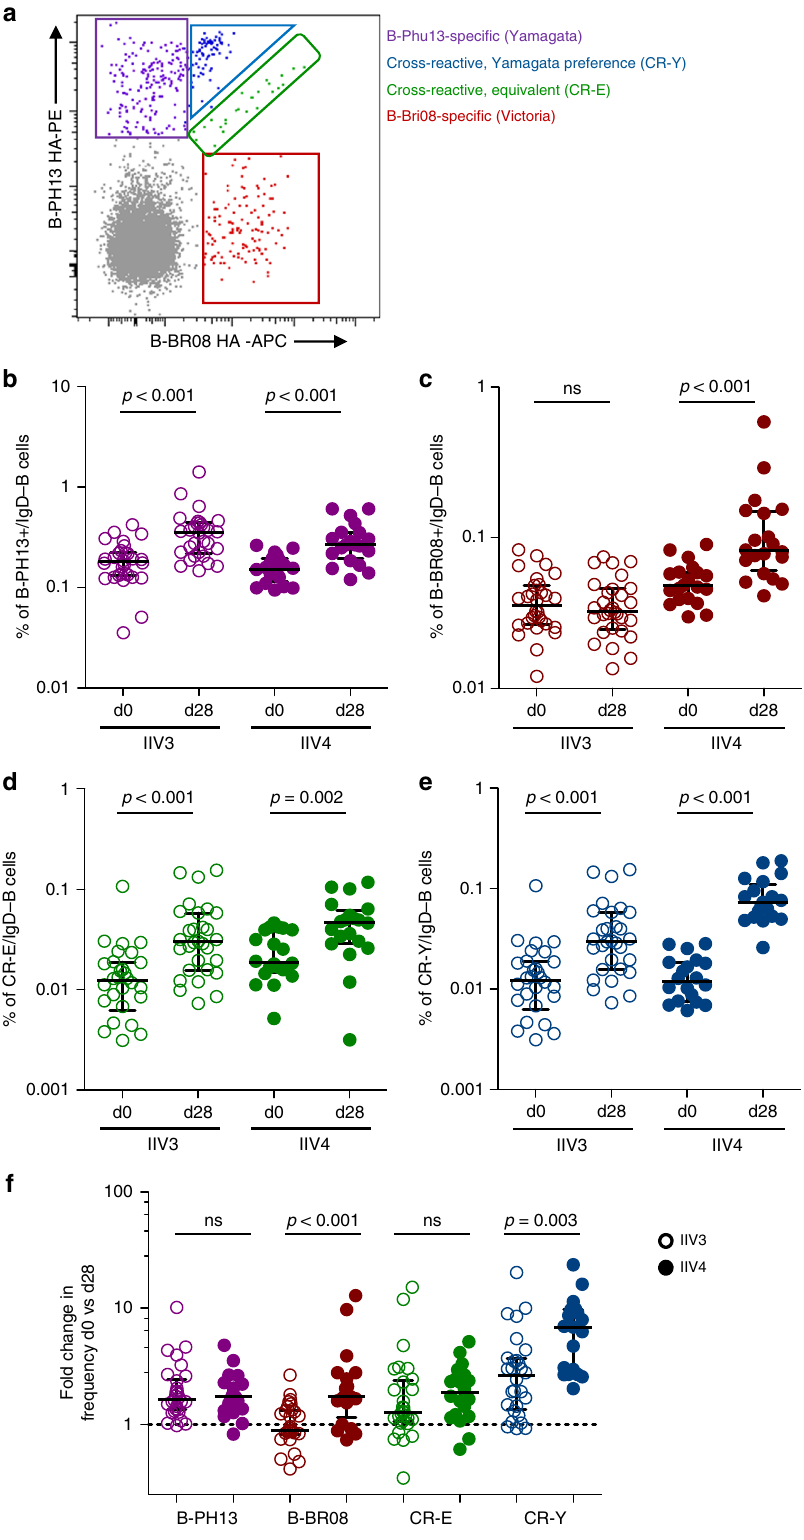
Fig. 2 Cross-reactive memory B cell responses to IBV HA following IIV3 and IIV4 immunisation. a Co-staining class-switched memory B cells with B/ Phuket/3073/2013 (B-PH13) and (B/Brisbane/60/2008) B-BR08 probes allowed the delineation of four distinct populations of B cells: B-PH13 (purple) and B-BR08 speci fi c (red), and two cross-reactive populations — one binding each B lineage equivalently (CR-E; green) and one with increased staining intensity for the Yamagata antigen B-PH13 (CR-Y; blue). Frequencies of memory B cells at baseline (d0) and d28 post-immunisation for b B-PH13 speci fi c, c B-BR08 speci fi c, d CR-E and e CR-Y populations. f Fold change in B cell frequency of each population between d0 and d28. Data are shown as median ± interquartile range. Populations were compared using Mann – Whitney U tests and p values are denoted. ns not signi fi